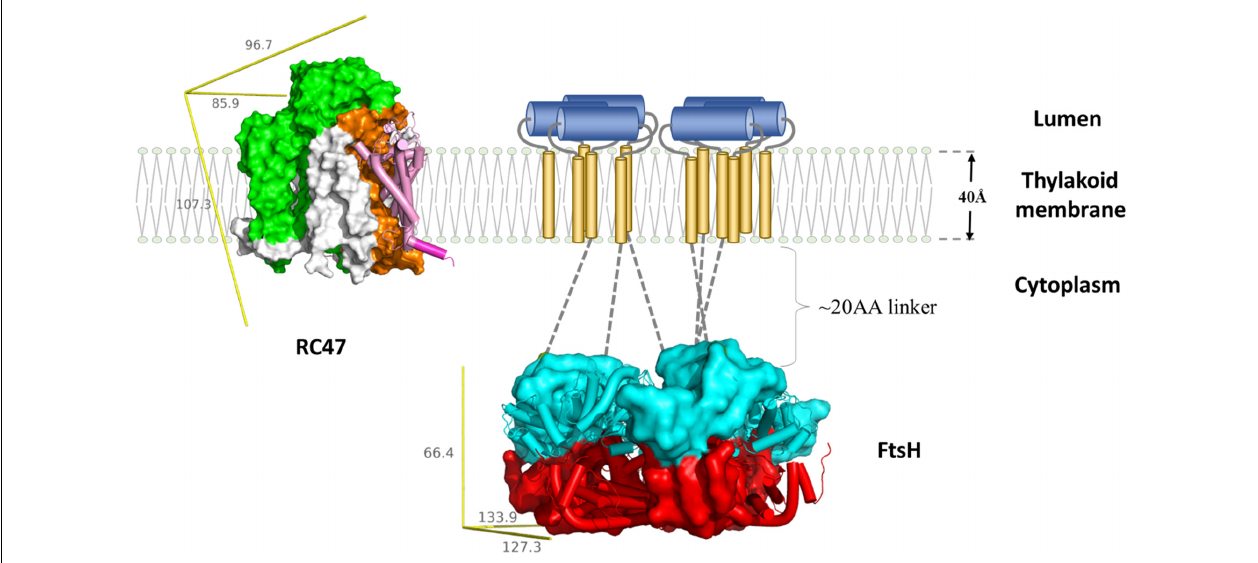
FIGURE 3 | Schematic representation of FtsH-mediated D1 degradation. Upon inactivation, PSII undergo partial disassembly, resulting in transient complex RC47 (PDB:4V62) containing inactivated D1 (pink and purple), D2 (orange), CP47 (green), and small chlorophyll-binding subunits (white). The N-terminal loop of D1 (purple cylinder) is exposed for degradation. The thylakoid FtsH complex (adapted using crystal structure of the whole cytosolic domains of FtsH from T. thermophilus , PDB:2DHR) participates in D1 removal. In the current model, the N-terminal D1 loop feeds through the FtsH linker region (gray dotted lines) and is pulled by the ATPase domains (cyan) down the central pore, and translocated to the protease domain (red). Both RC47 and FtsH complexes are plotted to scale using the lipid membrane as size reference. The missing transmembrane region of FtsH is illustrated as a cartoon: transmembrane helices (gold cylinders) and lumenal region (blue cylinders). The yellow reference rulers represent the dimension (unit: Å) of the Inertia Axis Aligned Bounding Box (IAAB) for the respective protein, which are calculated by Guardado-Calvo’s Python scripts for pymol (https://pymolwiki.org/index.php/Draw_Protein_Dimensions).